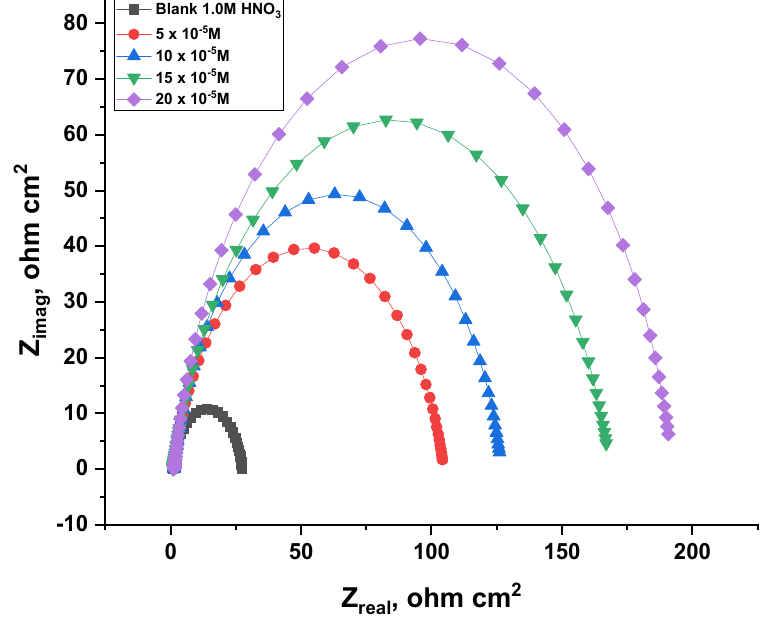
Figure 14. An analysis of the Nyquist plot for copper dissolution in 1.0 M HNO 3 solution in the absence and presence of numerous doses of ACR-2.